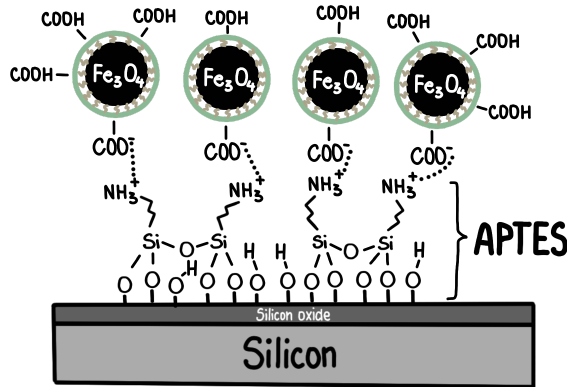
Figure 3. Diagram showing the amine bond between the silane group of the APTES coating on the substrate and the carboxylic group of the ligands in the NPs’ shells [50].